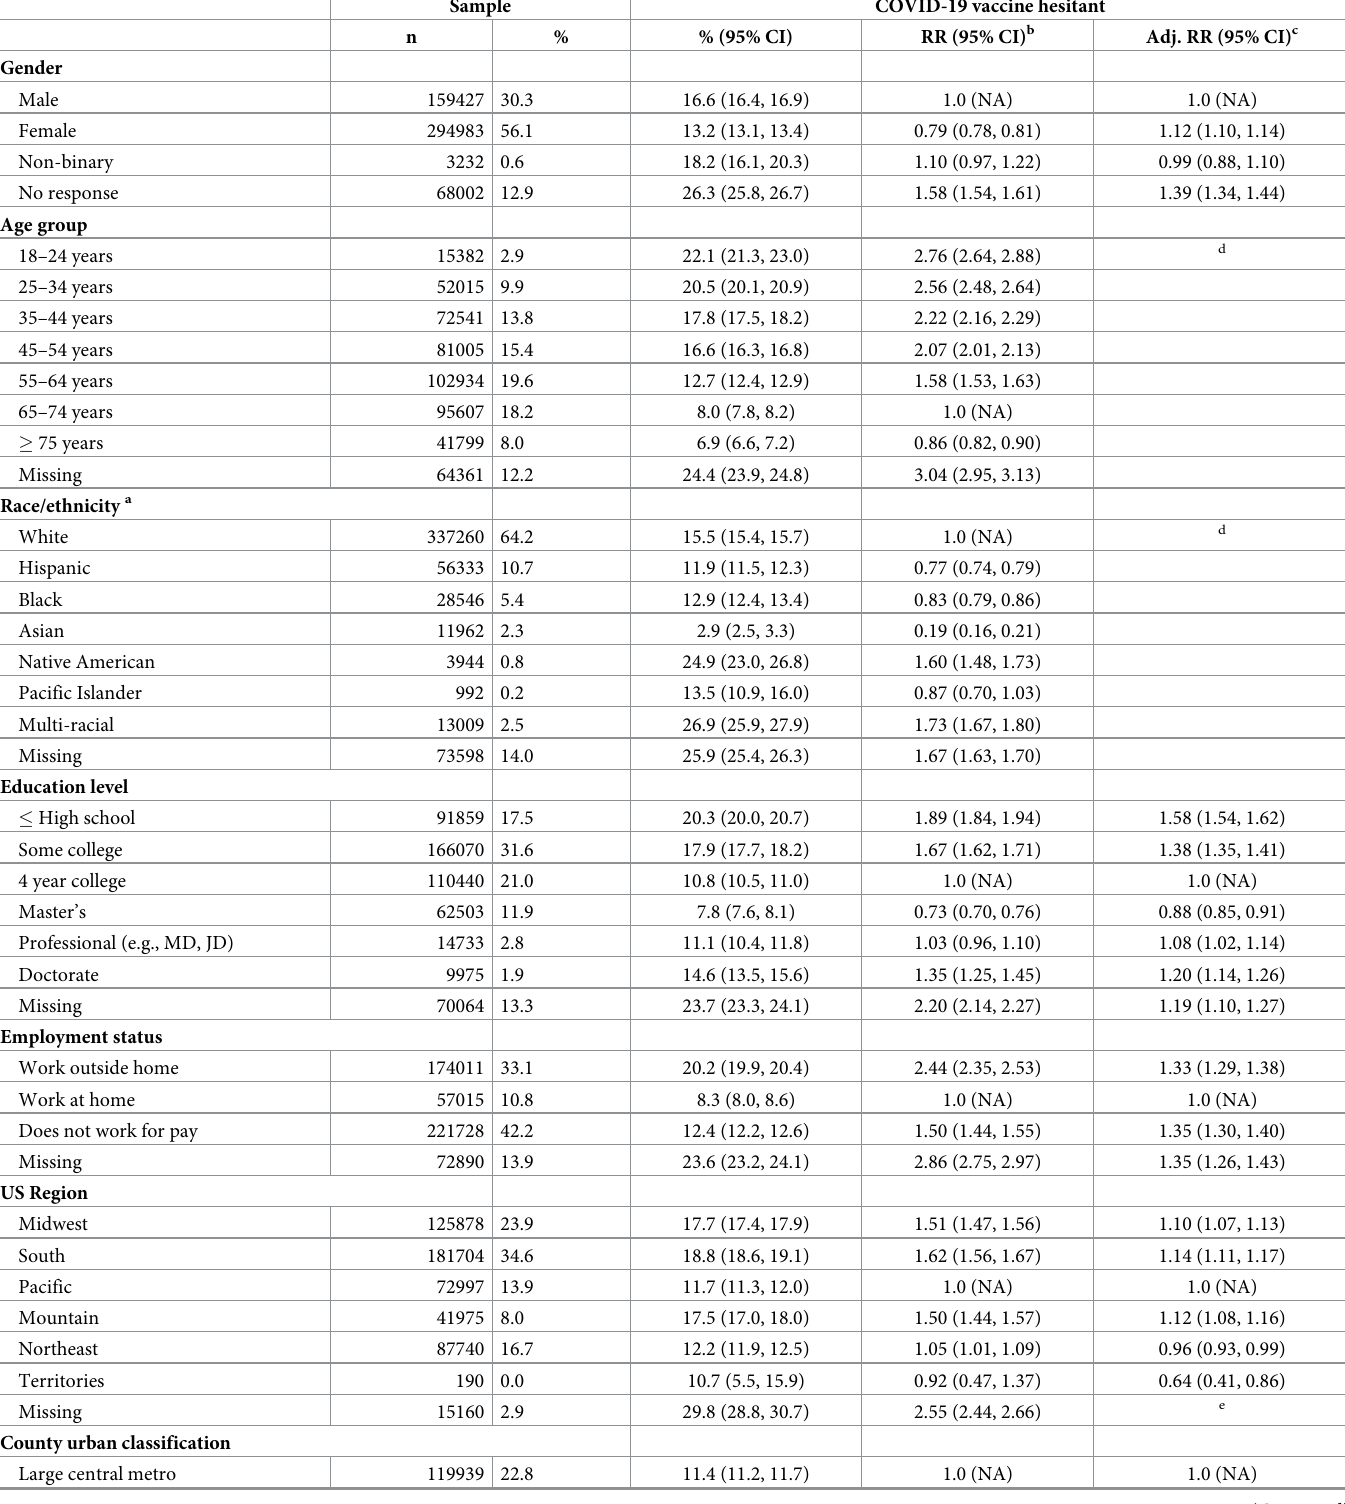
Table 1. COVID-19 vaccine hesitancy in May 2021 by demographics among US adults (N =